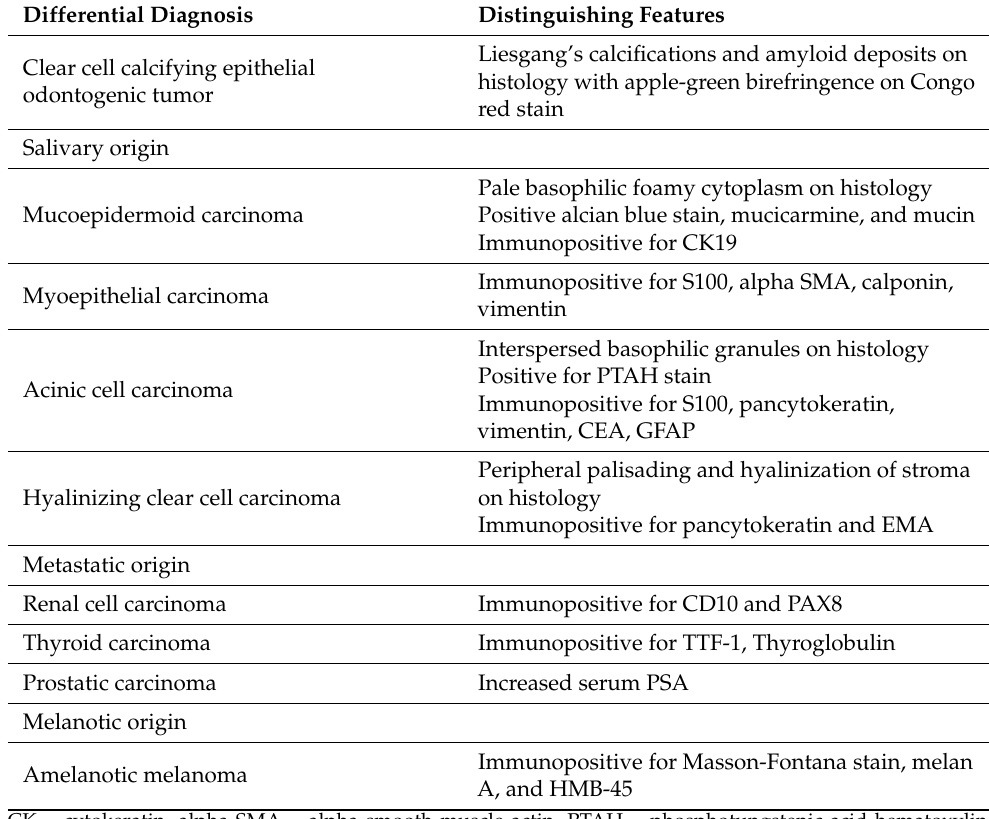
Table 2. Cont. Differential Diagnosis Distinguishing